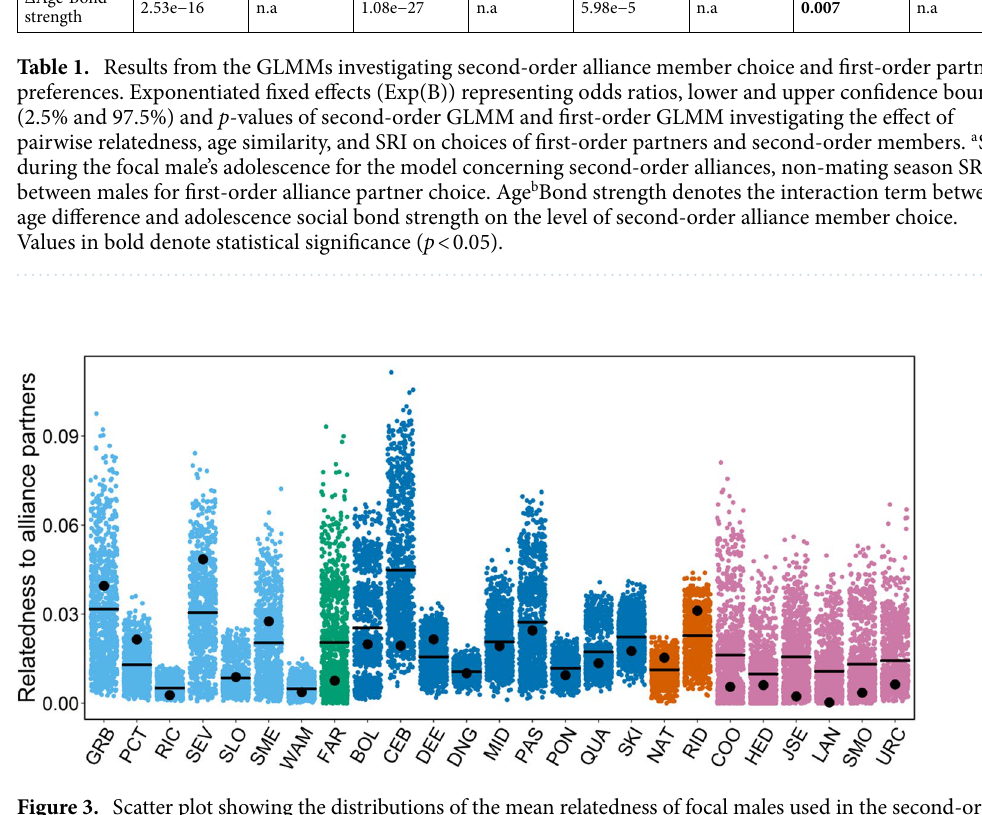
Figure 3. Scatter plot showing the distributions of the mean relatedness of focal males used in the second-order GLMM to randomly formed second-order alliances obtained from simulations. The mean of 1000 simulations per male is represented by the black line. The mean relatedness value of a focal male to its observed chosen second-order alliance members is displayed as a black circle. Different colours denote second-order alliance